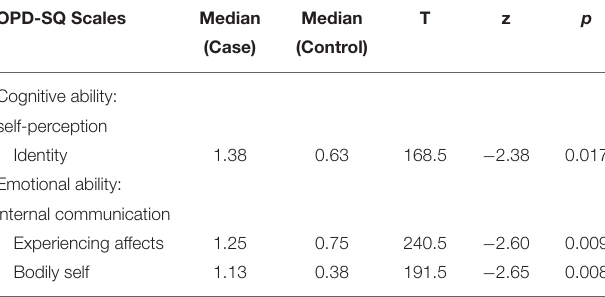
TABLE 4 | Comparison of OPD-SQ scores (wilcoxon test).